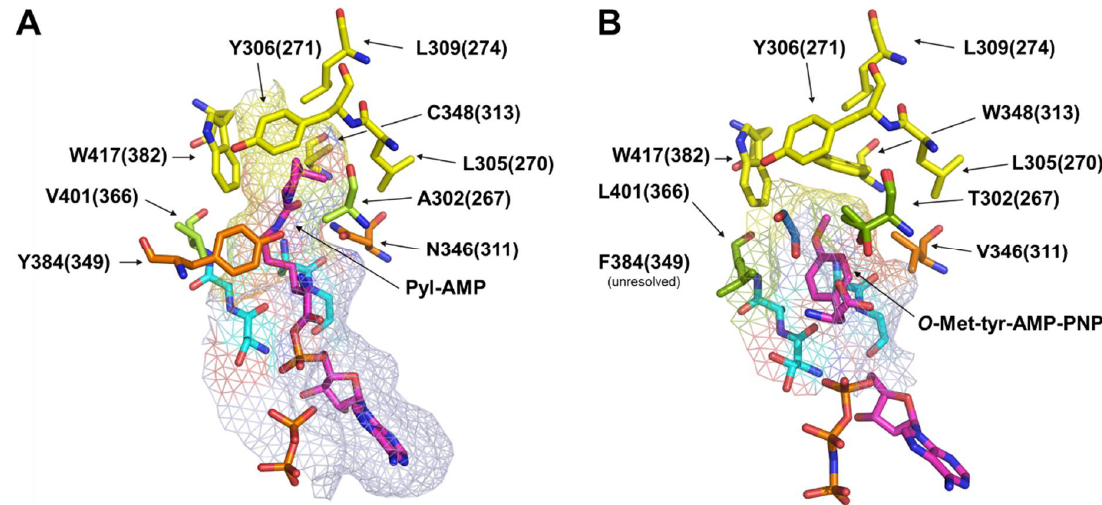
Figure 2. Microenvironment of the active sites derived from the crystal structures of Mm PylRS and the Mm OmeRS mutant. These structures guided the rational mutation approach. Shown are critical residues forming the active site. Since only structures of M. mazei are available, these were used in a homology model for M. barkeri . Residue numbers in brackets reflect the numbering of M. barkeri, while numbers not in brackets refer to M. mazei . ( A ) Wild-type Mm PylRS (PDB ID: 2Q7H)[20] with bound Pyl-AMP. ( B ) Mutant Mm OmeRS (PDB ID: 3QTC)[32] with bound O -Methyl-tyrosine-AMP-PNP ( O -Met-tyr-AMP-PNP).